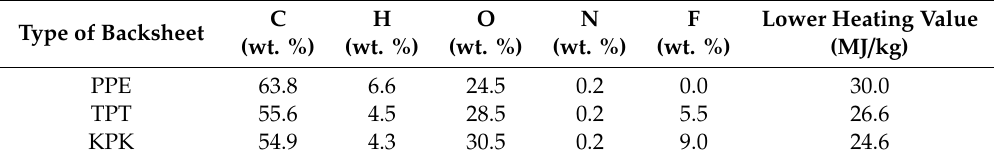
Table 2. Ultimate analysis and heating values of the backsheet